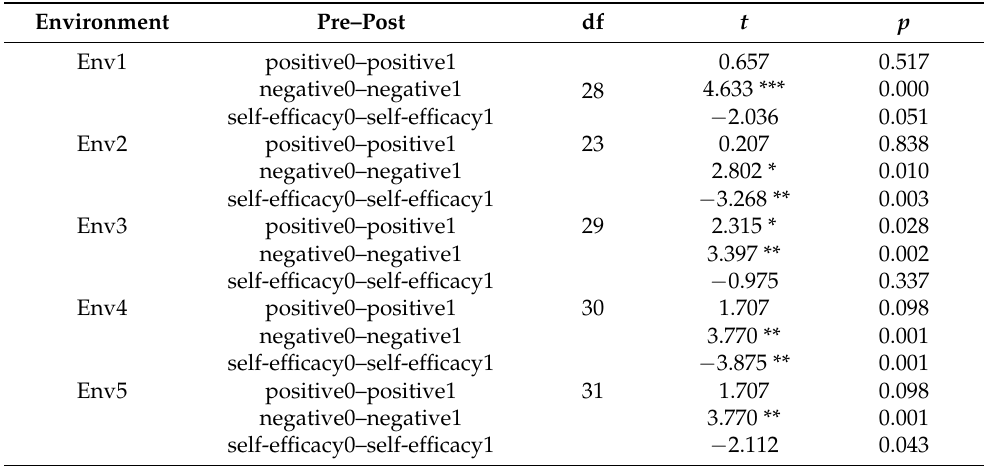
Table 2. Paired sample t -test results of positive and negative affect and general